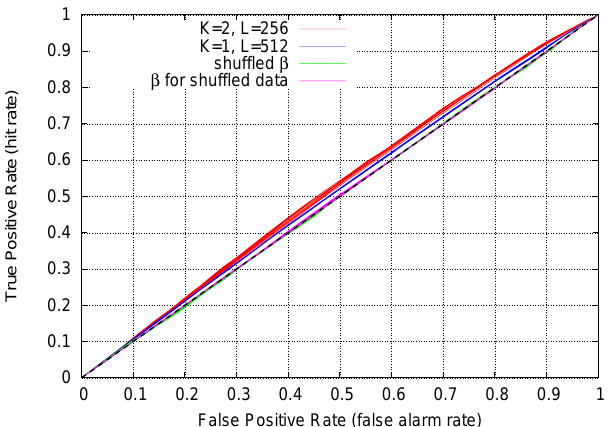
Fig. 3. (color online) The ROC diagram for the OFC earthquake model discussed in the text: red ( L = 256 and K = 2) and blue ( L = 512 and K = 1) lines. In addition, two ROC diagrams are depicted based on the results obtained for L = 512 and K = 1: the green curves correspond to the case when the values of β k were randomly shuffled and the shuffled predictors were used, while the magenta curves when the time series of Q k was randomly shuffled and then β k was estimated.